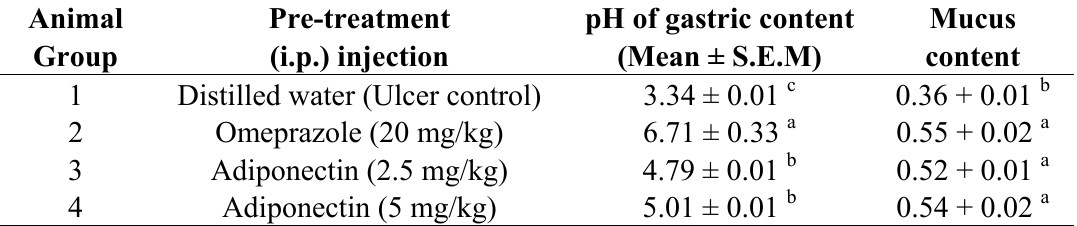
Table 7. Effect of adenopectin on pH of gastric content and mucus in rats.